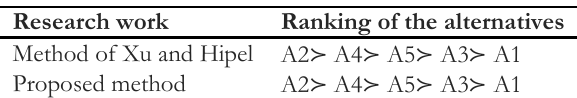
Table 8. Comparison with other